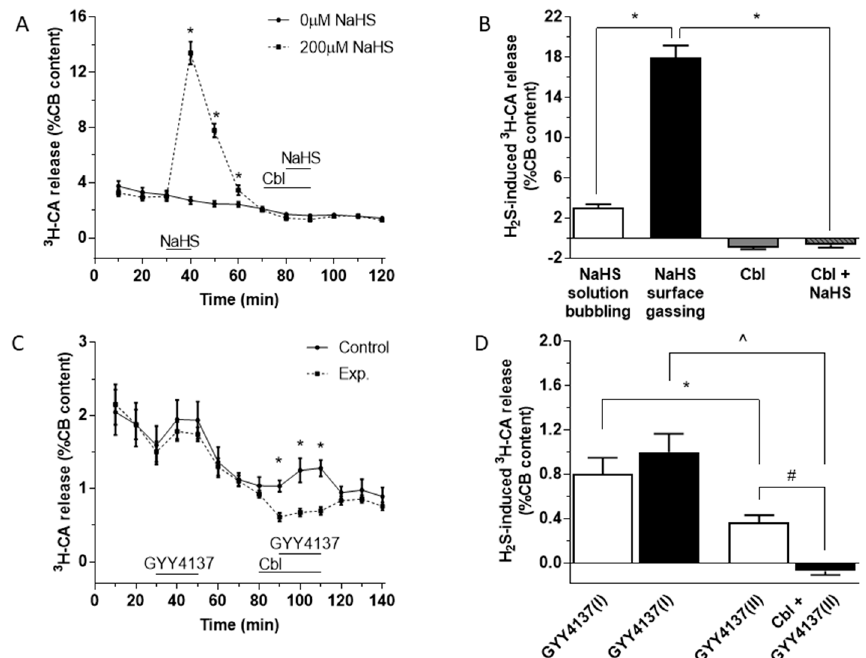
Figure 1. Effect of NaHS and GYY4137 on the release of 3 H-CA by CB chemoreceptor cells in the presence and absence of Cbl. ( A ) Time course of catecholamine release elicited by 200 µM NaHS applied for 10 min. A second application of NaHS was in the presence of 300 µM Cbl (n = 6 and 8, for 0 and 200 µM NaHS, respectively). ( B ) The black bar shows the magnitude of the release response corresponding to the area under the curve in part A. The empty bar represents the release response obtained for 200 µM NaHS in similar experiments in which the solution rather than the headspace was gassed. The small columns in grey at the right of the figure show that 300 µM Cbl abolished the effect of NaHS, and that when applied alone Cbl caused a modest inhibition of the basal ongoing release of catecholamine (NaHS solution bubbling, n = 2; NaHS gassing surface, n = 8; Cbl, n = 18; Cbl + NaHS, n = 10). ( C ) Effect of GYY4137 on the release of 3 H-CA in the absence and presence of Cbl. 400 µM GYY4137 was applied for 20 min by itself at 30 and 90 min (continuous line); 400 µM GYY4137 was applied for 20 min by itself at 30 min and then again at 90 min, this time in the presence of 300 µM Cbl, which had been applied at 80 min (dashed line). n = 10 in each condition. ( D ) The bars show the amplitudes of the two successive responses to GYY4137 (area under the curve) when both responses were evoked in the absence of Cbl (empty bars) and when the second response was elicited in the presence of Cbl. Symbols indicate where there was a significant effect.